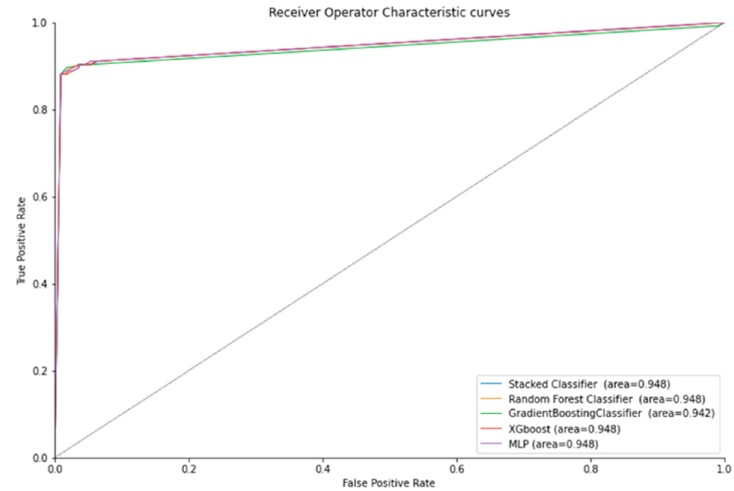
Figure 5. The ROC curve for the credit card dataset.